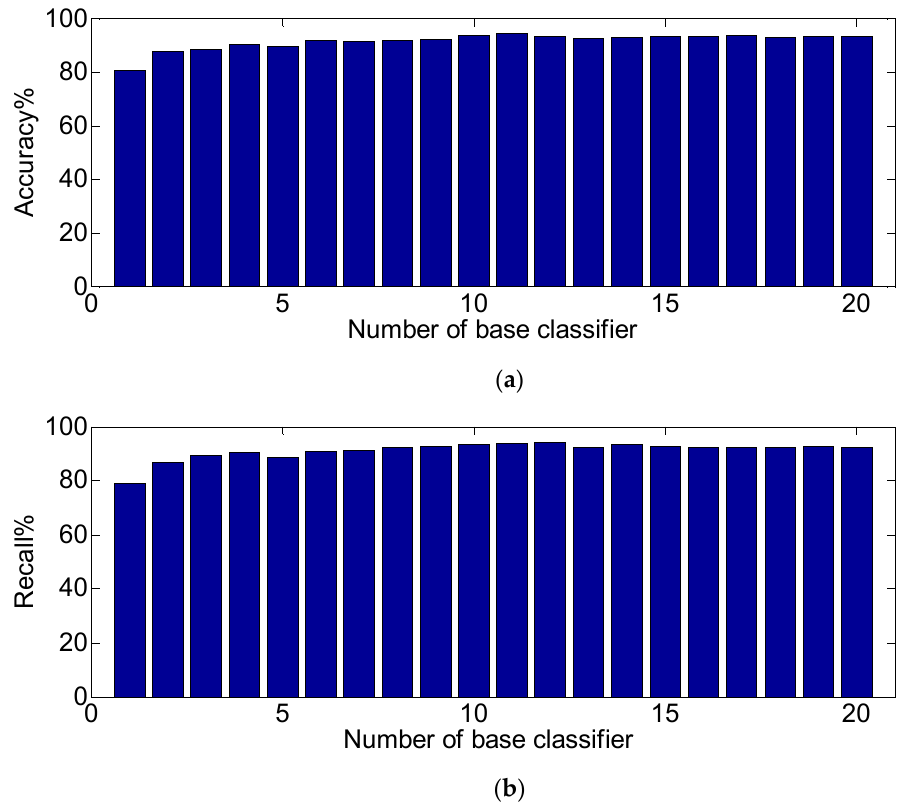
Figure 13. Performance of the multiclassifier system under different numbers of base classifiers: ( a ) accuracy of the multiclassifier system and ( b ) recall of the multiclassifier system.